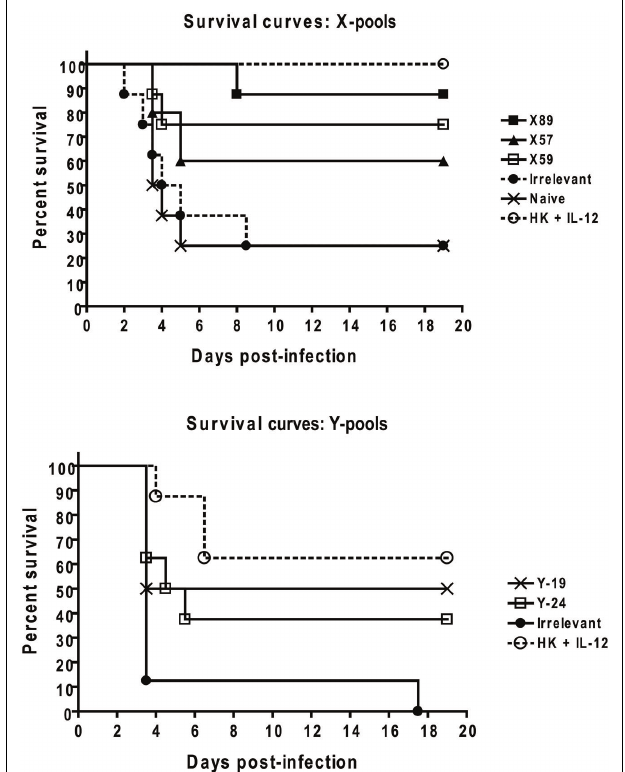
FIGURE 2 | Screening of the B. mallei ORF-ome for vaccine candidates by ORF-pool immunization and challenge–protection assay. Groups of eight mice were immunized once in each ear pinna with 1 μ g dose by gene gun. Each discharge carried a pool of B. mallei ORFs as LEEs (0.9 μ g) and the genetic adjuvant LTA/B (0.1 μ g).The LTA and LTB-expressing LEEs were mixed 1:5 (0.08 and 0.02 μ g, respectively).Two libraries of 5750 ORFs, labeled X andY, were partitioned into 96 pools of 60 ORFs (X-pools) or 48 pools of 120 ORFs (Y-pools). Controls were heat-killed (HK) B. mallei , the non B. mallei antigen α 1-antitrypsin (AAT), and naïve mice. Boosts were similarly administered at week 6. A 2 LD 50 (1 × 10 5 ) dose of live B. mallei ATCC23344 was administered i.n. at week 10 and death was monitored twice daily. Survival curves were generated for all groups; however, only the curves corresponding to statistically protective groups ( p < 0.05) and controls are plotted for clarity.Top graph displays results from animals immunized with protective pools from the X library. Bottom graph displays the survival courses of mouse groups administered the protective pools from theY